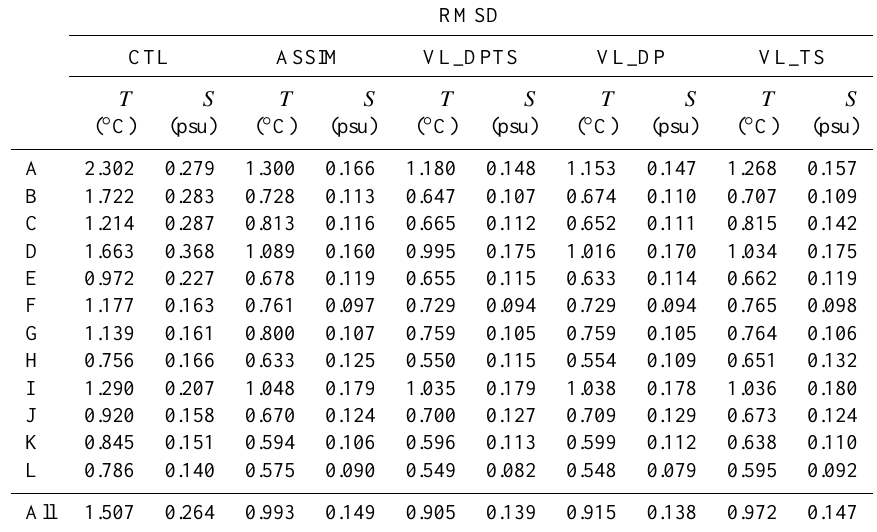
Table 1. RMSD of temperature ( ◦ C) and salinity (psu) to 2000m with respect to Argo data for the prior state of each experiment from 1 January 2010 to 31 December 2012. The calculations were performed for the whole model domain (100 ◦ W–20 ◦ E, 78 ◦ S–50 ◦ N) and for each one of the 12 sub-regions previously defined in Fig. 4.